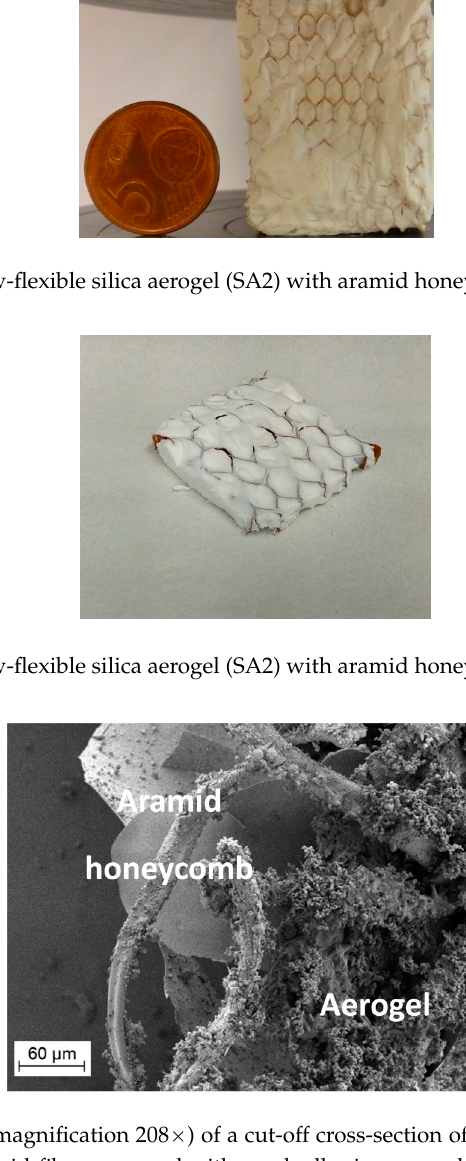
6 of 15 6 of 15 6 of 15